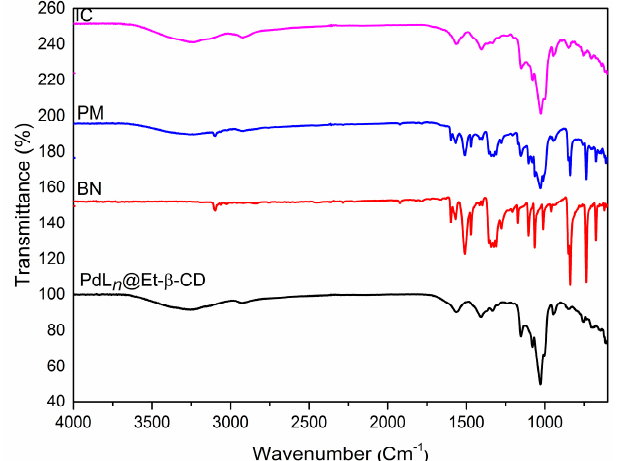
Figure 7. FT-IR spectra of PdLn@Et- β -CD, BN, a physical mixture of BN/PdLn@Et- β -CD (PM), and Figure. 7. FT ‐ IR spectra of PdLn@Et ‐β‐ CD, BN, a physical mixture of BN/PdLn@Et ‐β‐ CD (PM), and the BN/PdLn@Et- β -CD complex (IC). the BN/PdLn@Et ‐β‐ CD complex (IC).